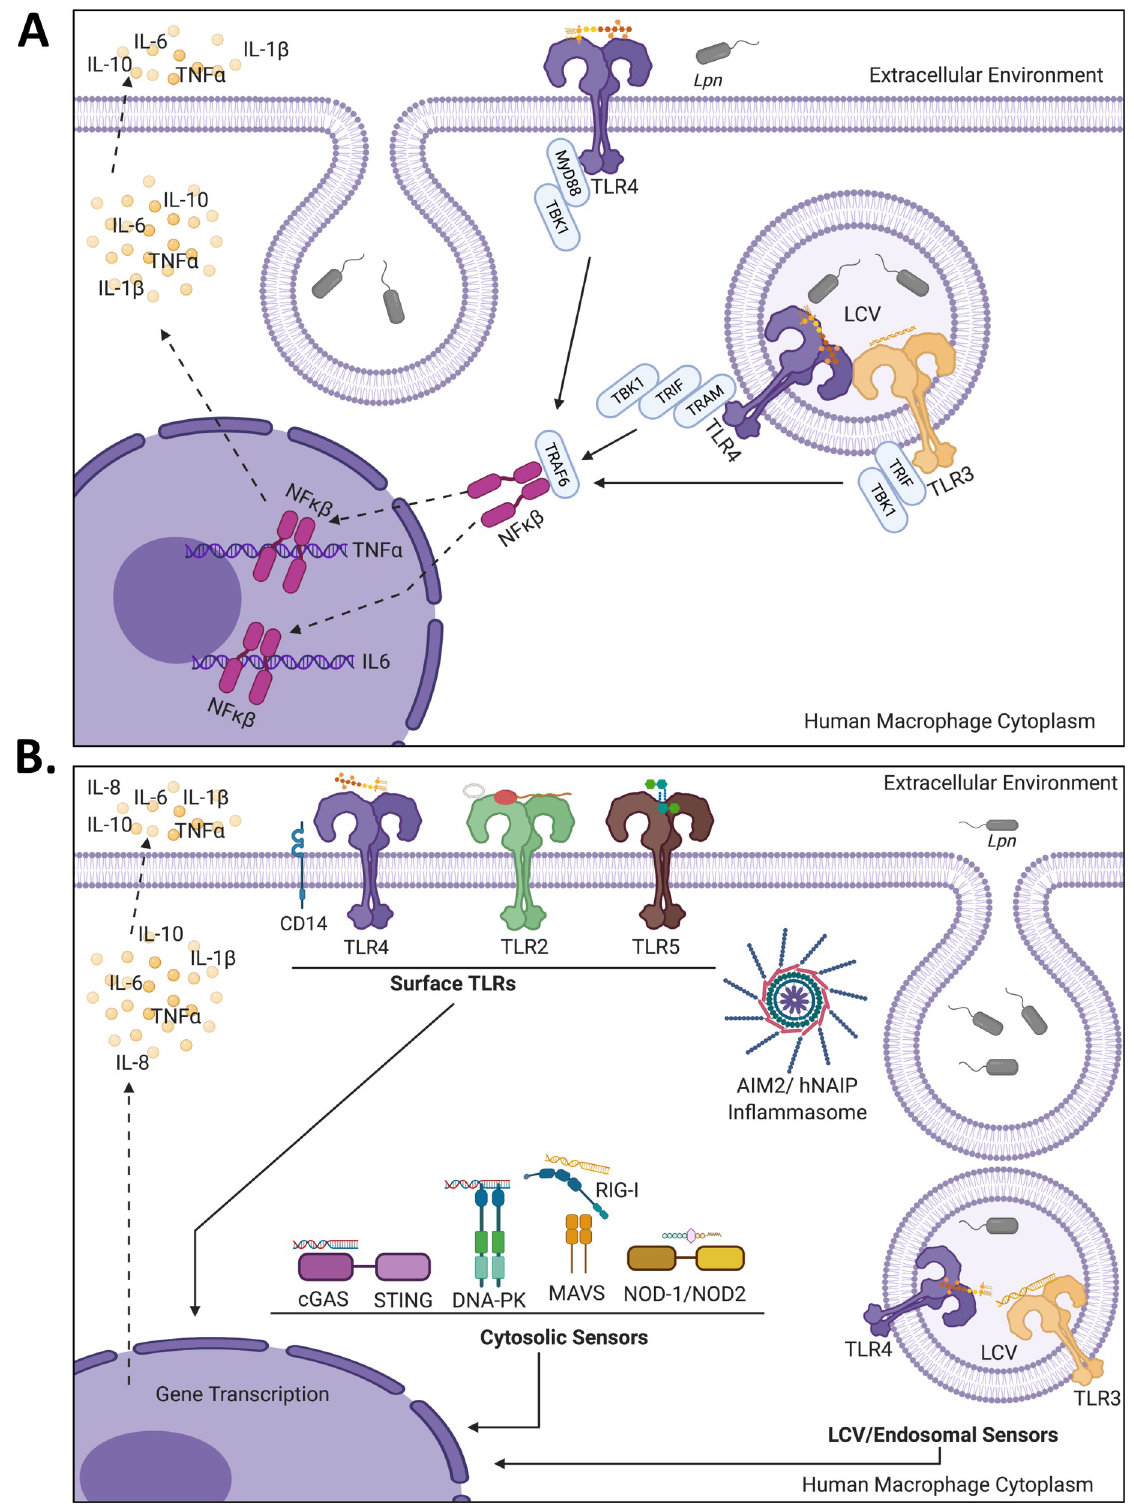
Fig 11. Summation of TLR3, TLR4, and other PPRs required for the human macrophage response to L . pneumophila infection. (A) The TLR3 and TLR4 signaling axes. TLR4 recognizes L . pneumophila ( Lpn ) LPS at both the macrophage surface and the endosomal / Legionella -containing vacuole (LCV) compartment. TLR4 at the surface signals via MyD88, whereas endosomal-localized TLR4 requires the